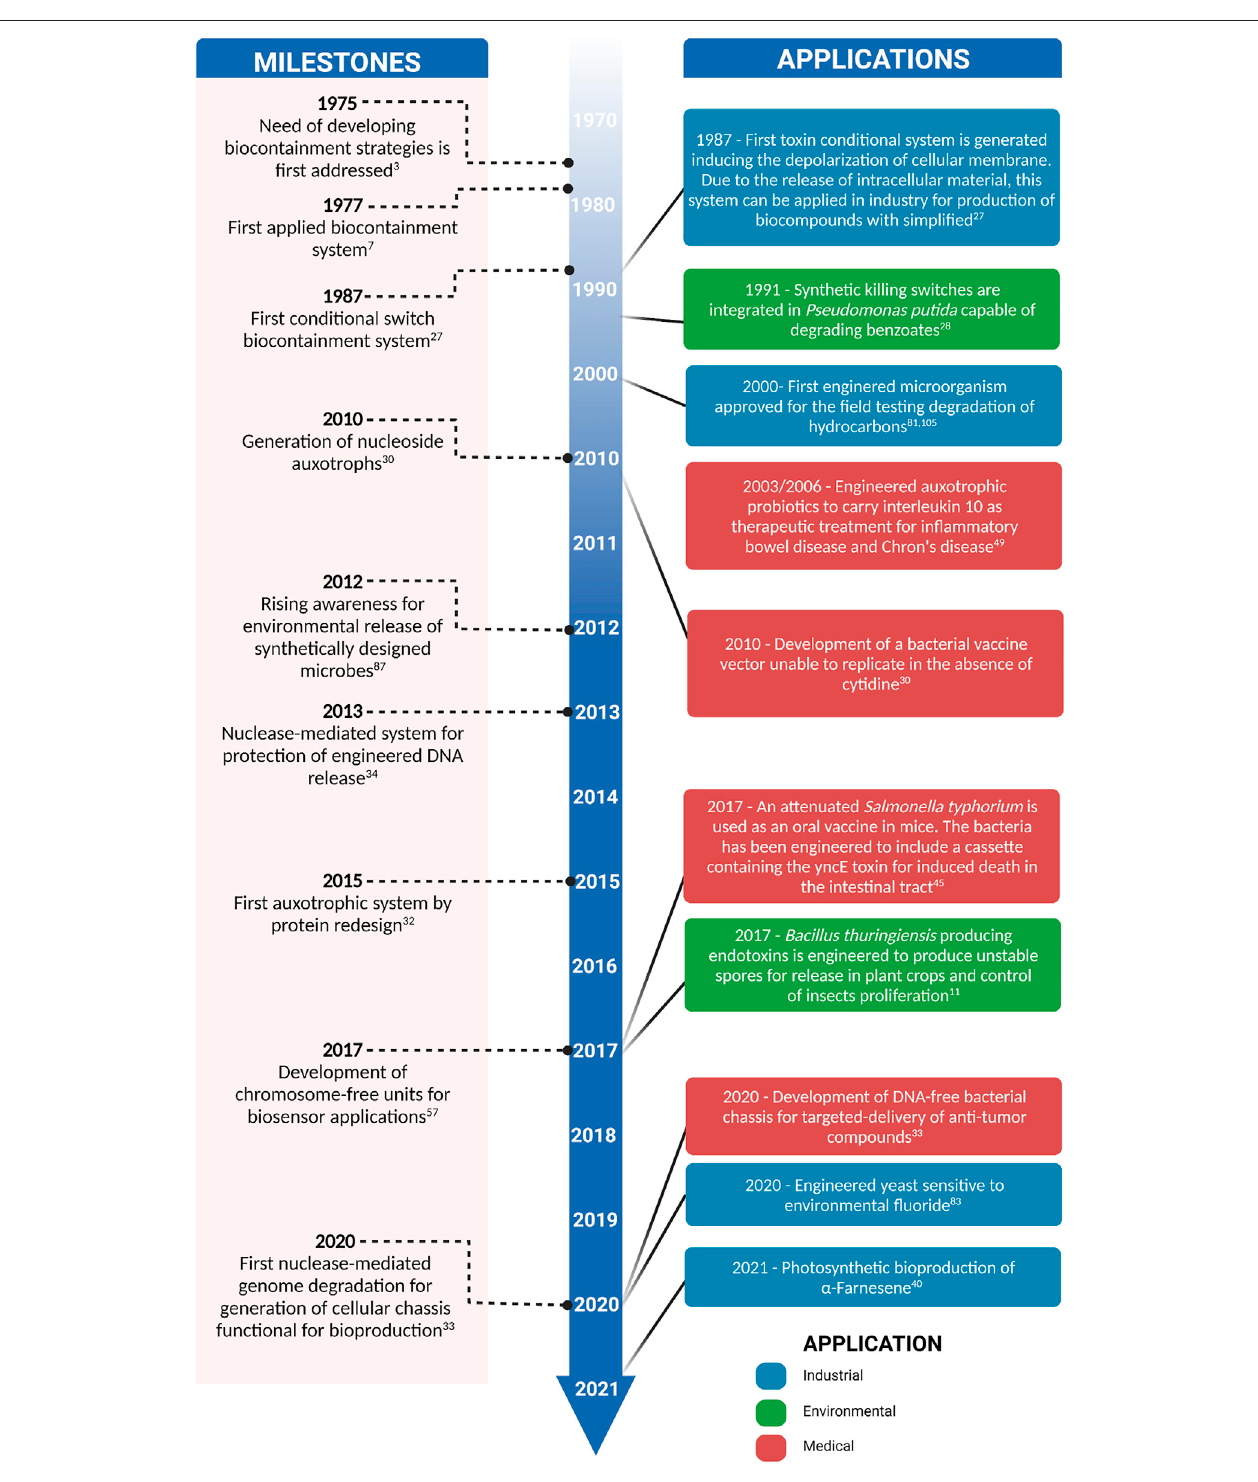
FIGURE 1 | Timeline of milestones in the development of microbial biocontainment systems and important applications in the environmental, industrial, and health fi elds.